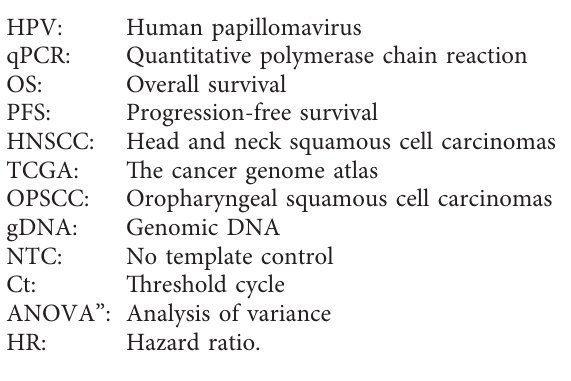
Supplemental Table 1: HPV Primer/probe sets. ( Supple- mentary Materials